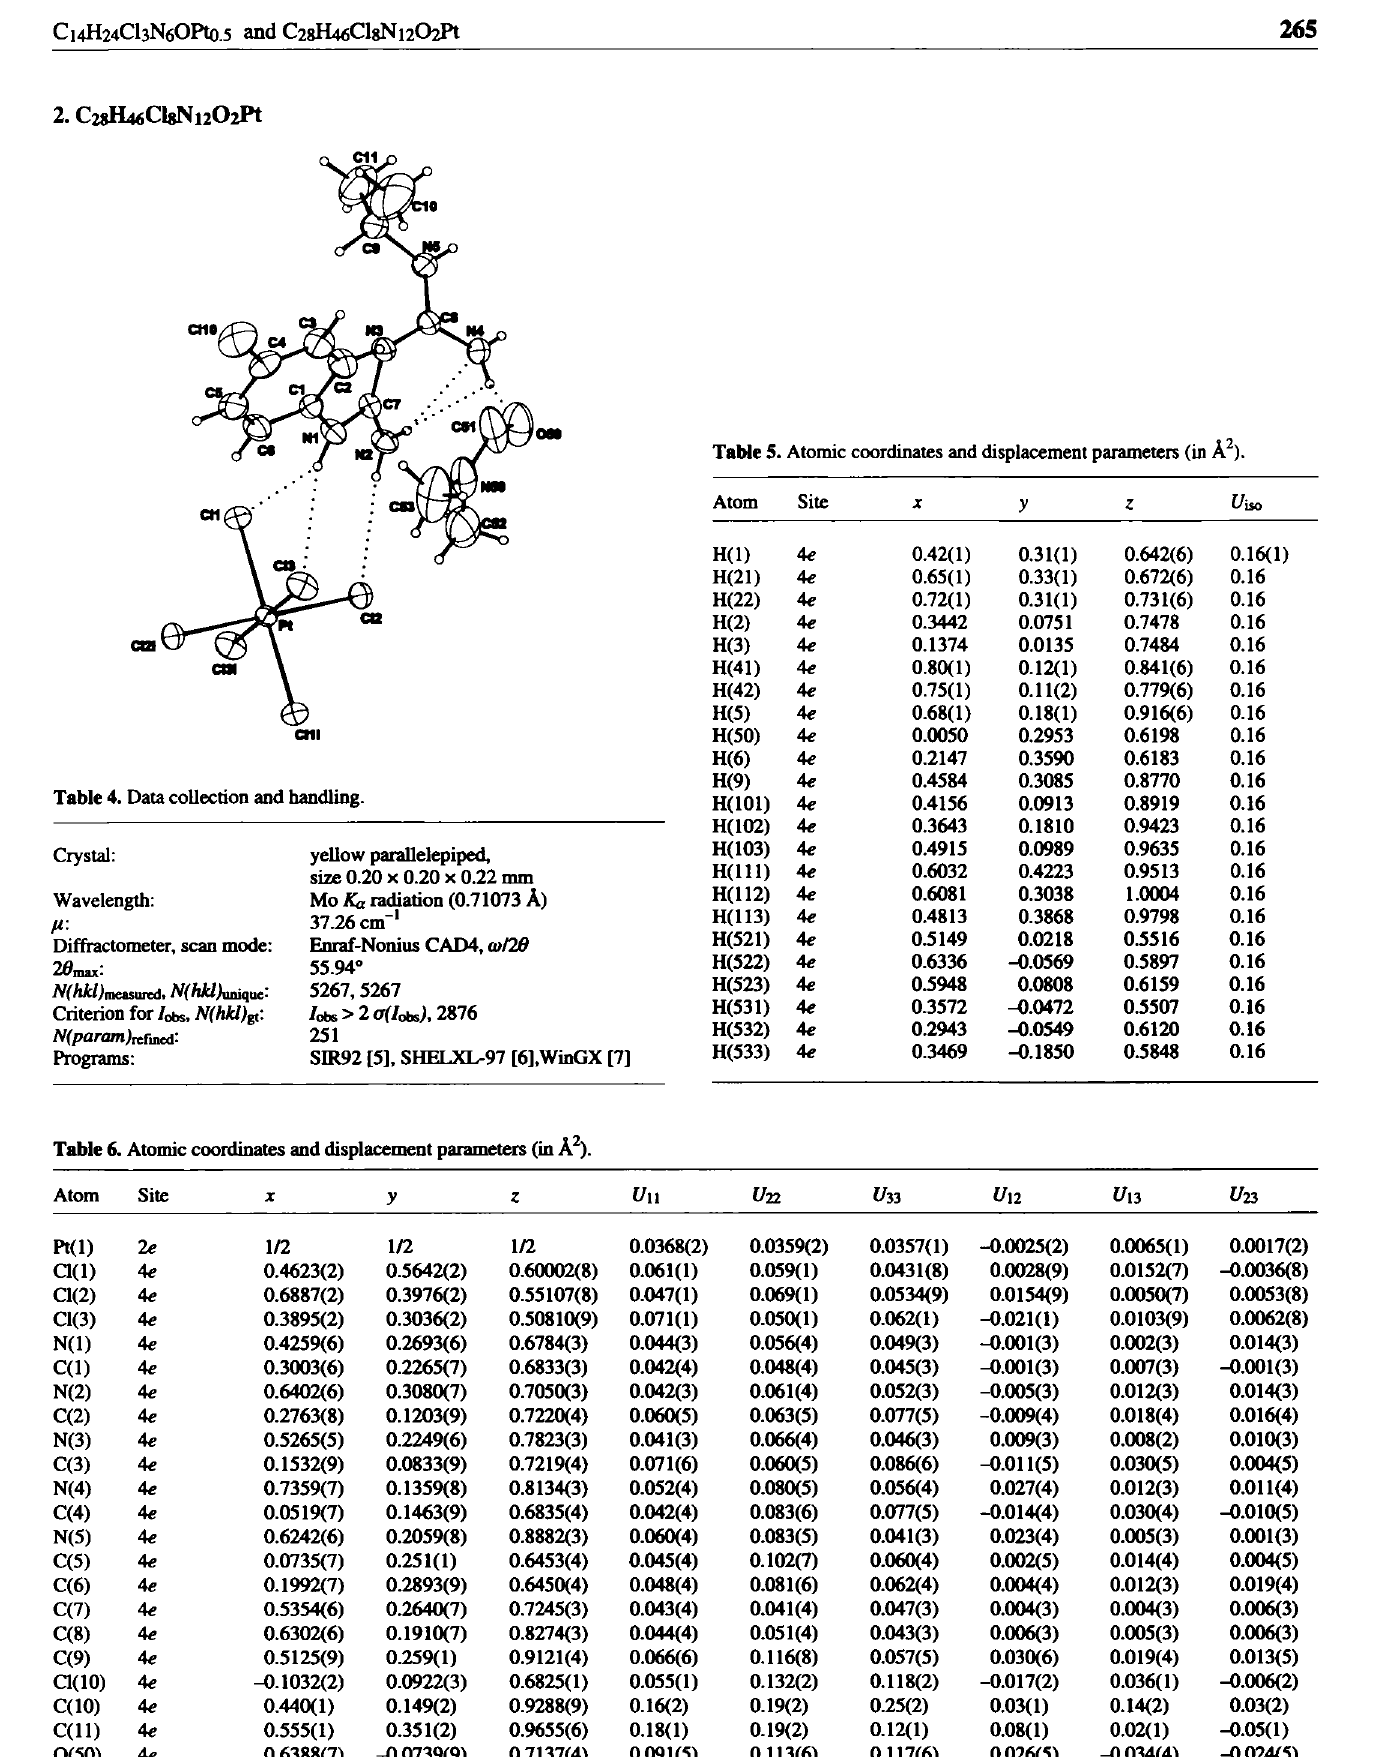
Table 6. Atomic coordinates and displacement parameters (in A 2